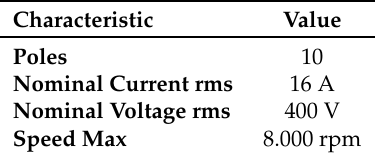
Table 3. 9-phase motor